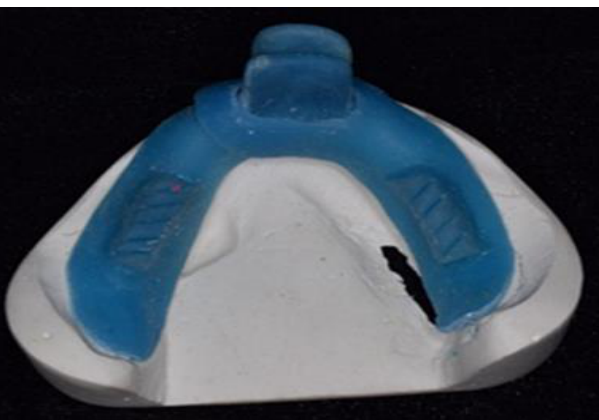
Fig. 3A. Maxillary sectional special tray.